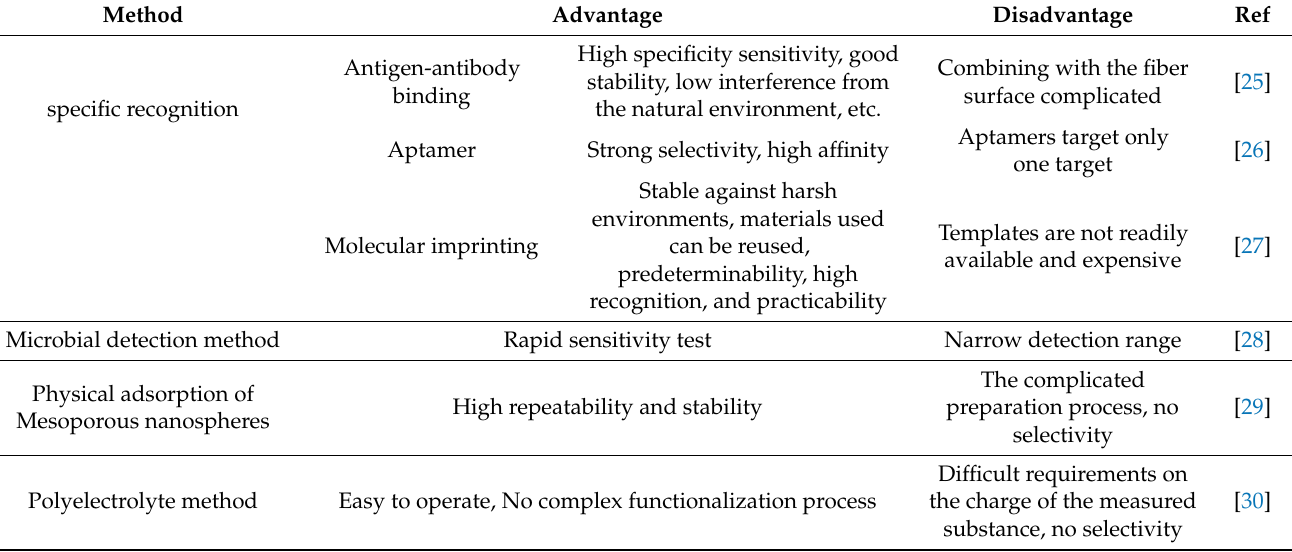
Table 1. The recognition method of the target detection